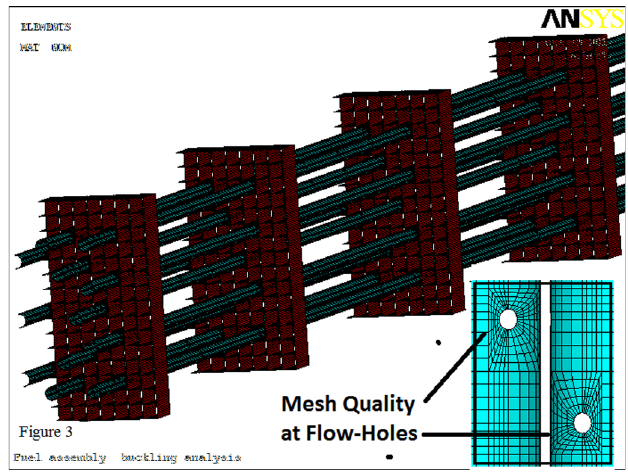
Fig. 3. Element plot of FE